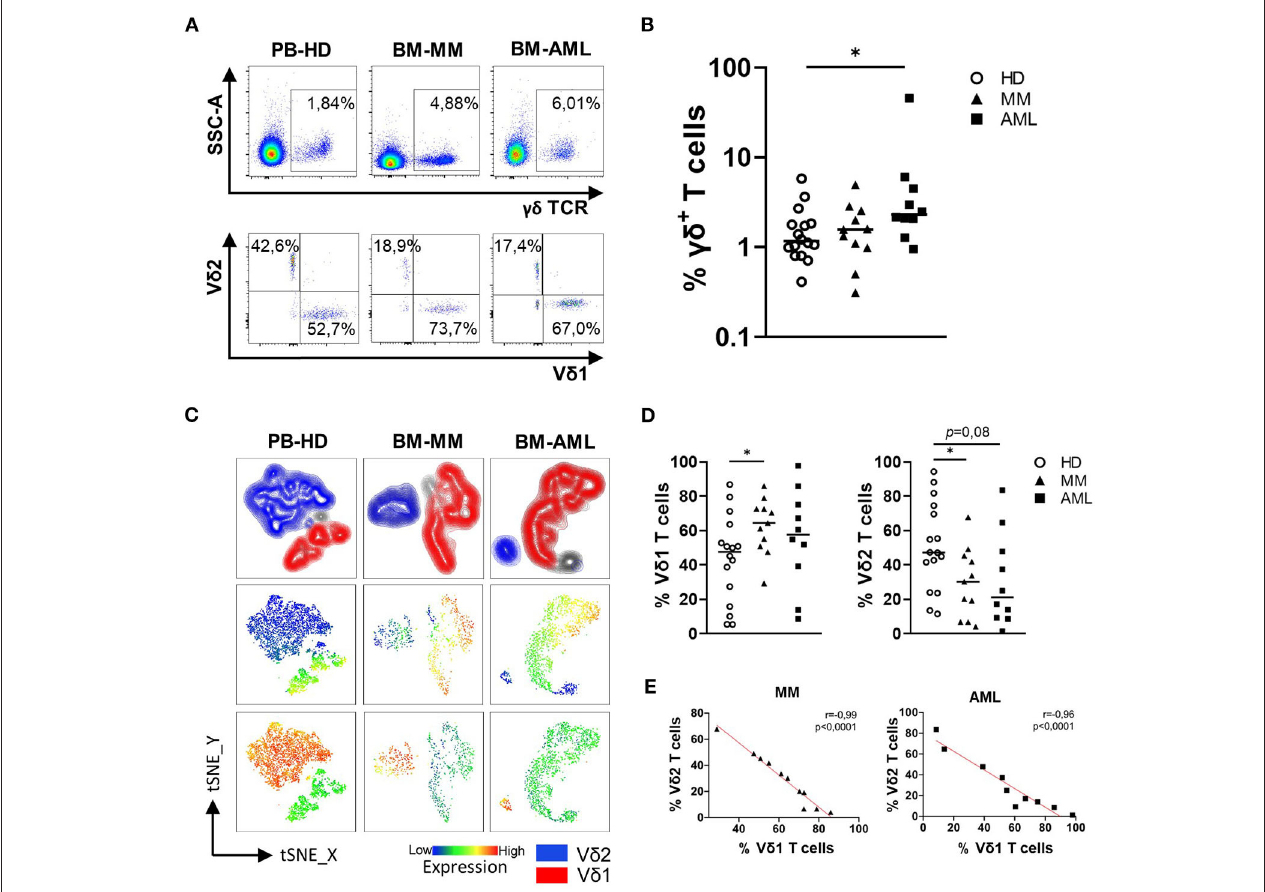
FIGURE 1 | The increased frequency of V δ 1 γδ T cells is associated with reduced infiltration of V δ 2 γδ T cells in AML and MM. Flow cytometric analysis of the co-expression of the γδ TCR and the V δ 1 and V δ 2 receptor on CD3 + T cells was performed for bone marrow (BM) samples from patients with AML (AML, black rectangles, n = 10), MM patients (MM, black triangles, n = 11), and peripheral blood (PB)-derived mononuclear cells from healthy donors (HD, white circles, n = 16). (A) Representative flow cytometry data show γδ T cells, V δ 1, and V δ 2 γδ T cells. (B) Summary data illustrate the frequency of γδ T cells in HD, AML, and MM. P -values were obtained by the Mann-Whitney test. * P < 0.05, ** P < 0.01, *** P < 0.001. (C) t-distributed stochastic neighbor embedding (tSNE) analysis delineate the distribution of V δ 1 and V δ 2 γδ T cells within the total γδ T cells in BM aspirates from four HDs (left graphs), four patients with MM (middle graphs), and four patients with AML (right graphs). (D) Summary data show the frequency of V δ 1 and V δ 2T cell subpopulations. P -values were obtained by the Mann-Whitney test. * P < 0.05, ** P < 0.01, *** P < 0.001. (E) Correlative analysis of the expression of the V δ 1 and V δ 2 receptors was performed for BM-derived aspirates of the MM and AML patients. Pearson’s test was used to test for